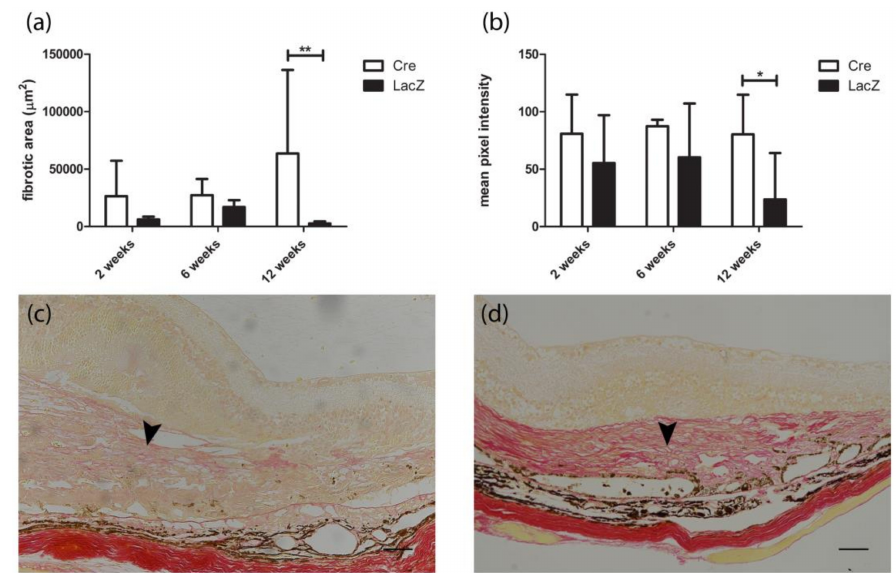
Figure 7. Fibrotic scarring in Sirius Red stained samples. ( a , b ) Subretinal collagen formation was seen at all time points in the Cre -injected group. Twelve weeks after LacZ injection, mild positive staining was seen only in two subretinally injected eyes. Intensity of the staining increased at later time points. ( c ) Faint positive collagen staining two weeks after Cre injection (arrowhead). ( d ) Subretinal fibrovascular membrane was clearly seen 12 weeks post- Cre gene transfer (arrowhead). Results are presented as mean ± SD. * p ≤ 0.05, ** p ≤ 0.01. Scale bar is 100 µ